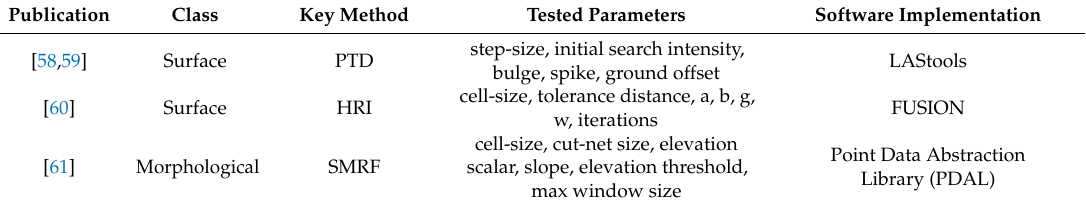
Table 4. Chosen ALS ground-point classification methods tested on DAP point clouds and their respective parameters and software